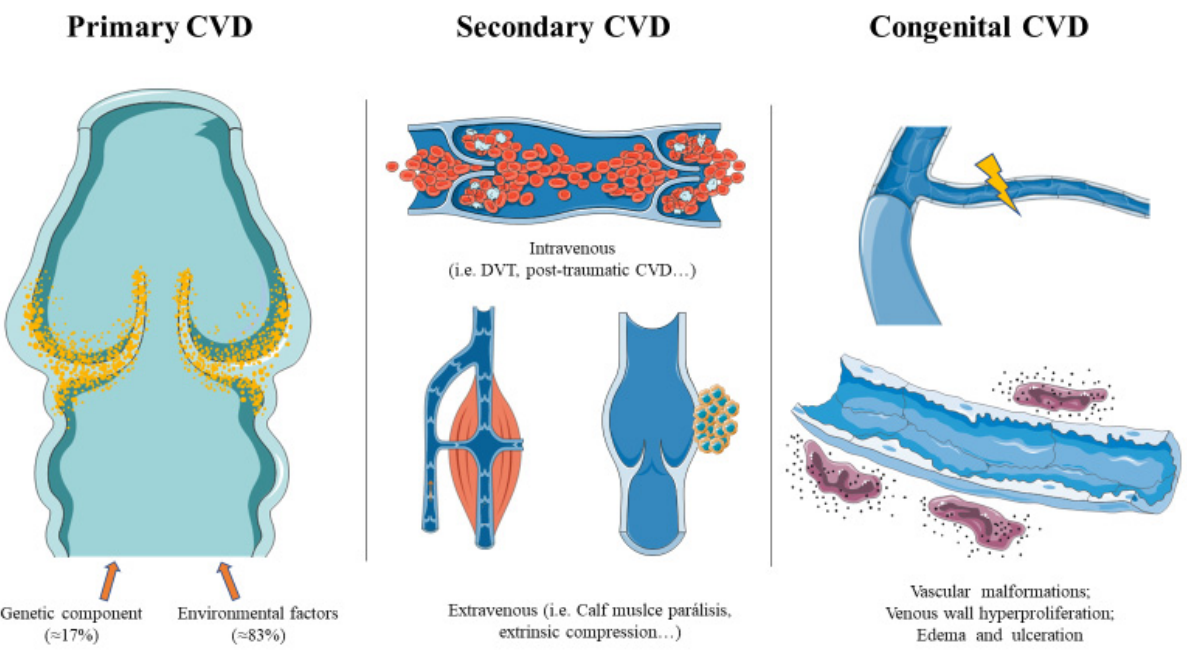
Figure 2. A general view on the different etiological mechanisms of CVD. Primary CVD (left) is caused by different genetic and environmental factors and it is characterized by a persistent venous hypertension responsible for the onset and progression of the disease. Secondary CVD (middle) is preceded by a pathological event, which could be intravenous (DVT) or extravenous (e.g., calf muscle dysfunction, extrinsic tumoral mass or arterial compression). Congenital CVD (right) represent a small percentage of the problem, and it is caused by single gene mutations or chromosomic aberrations.